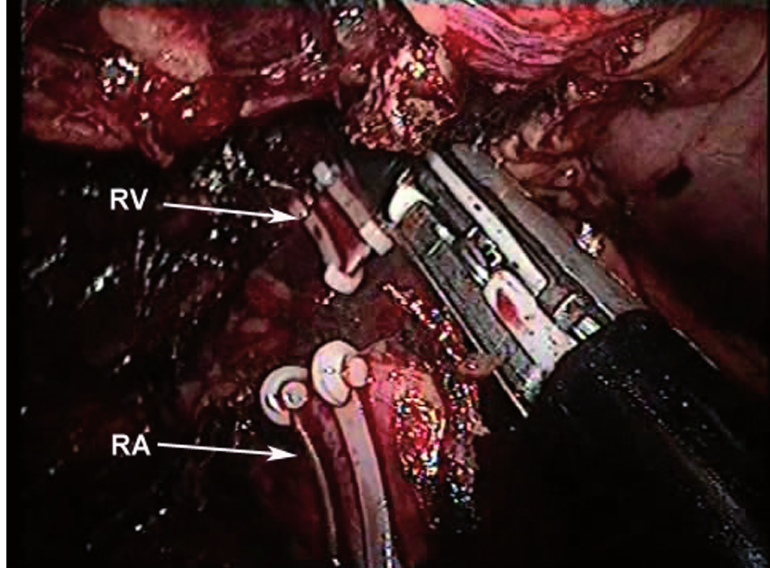
Figure 2 - The renal artery (RA) and renal vein (RV) were clipped with Hem-o-lok clips and divided by